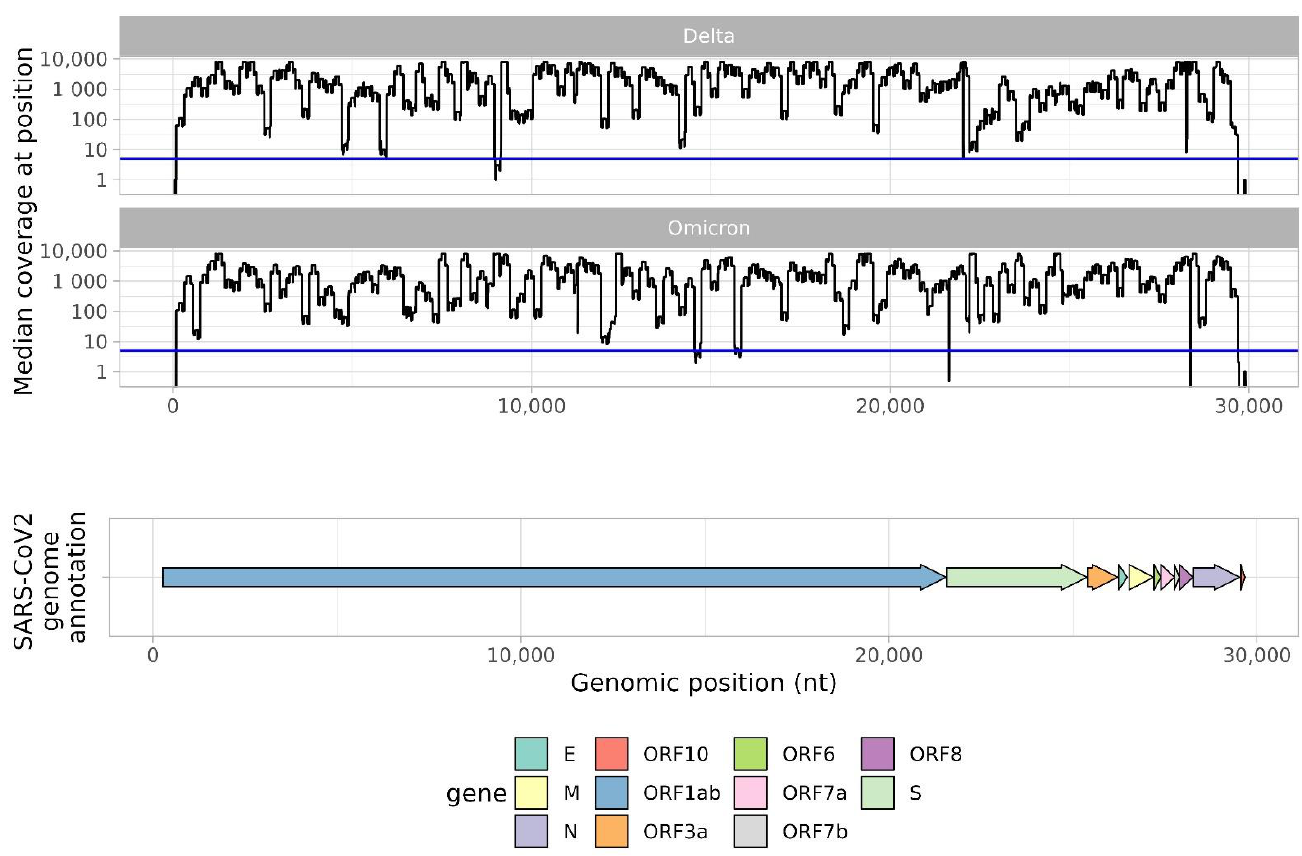
Figure 5. Median sequencing depth across the genome for Delta and Omicron SARS-CoV-2 samples prepared using the custom primer panel approach. The x -axis shows position in the SARS-CoV-2 genome. The y -axis shows median coverage (among 40 samples) by genomic position. The blue line represents a median coverage value of